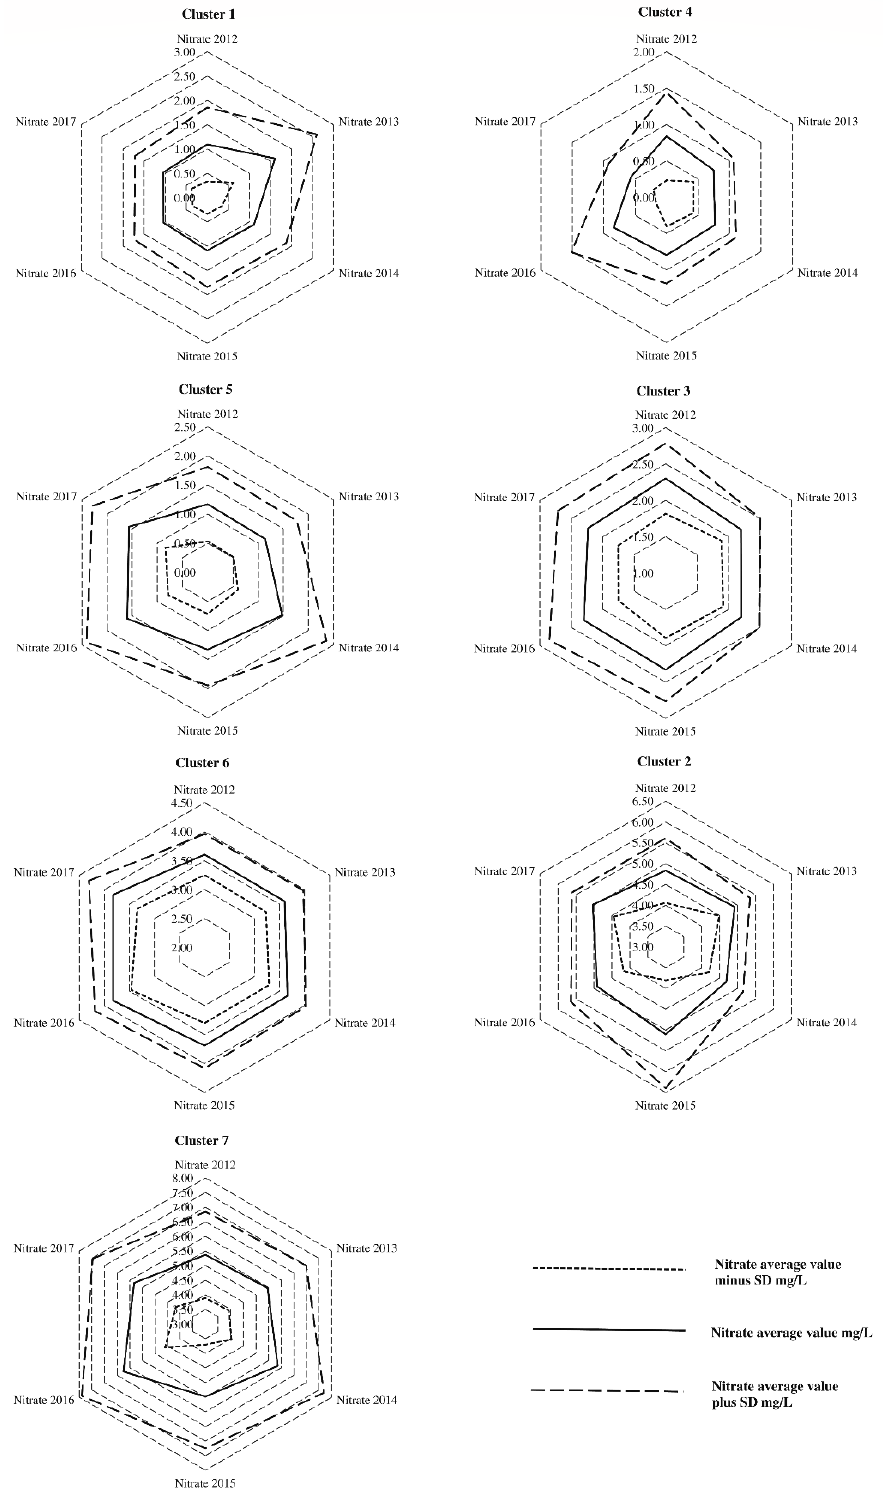
Figure 10. The change features of pre- and post-seismic groundwater nitrate concentration by adding standard deviation (SD) to each cluster.